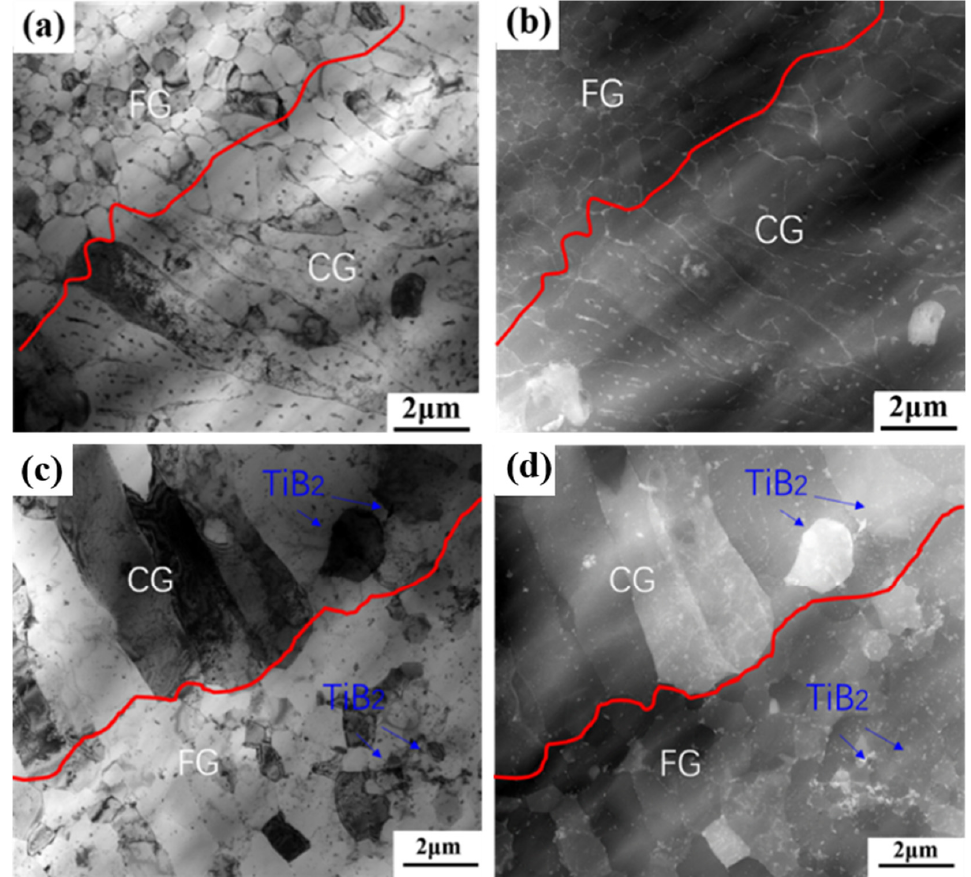
Figure 7. Morphological characteristics of equiaxed and columnar grain in TiB 2 /AlZnMgCu(Sc,Zr) composite under STEM, as-printed state: ( a ) bright filed ( b ) HAADF and heat-treated state: ( c ) bright filed and ( d ) HAADF.